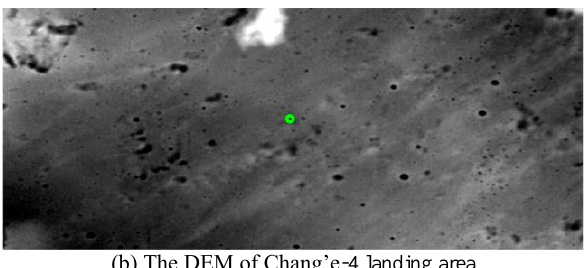
Figure 2. The DOM & DEM of Chang’e-4 landing area and the location of Chang’e-4 lander During the Chang’e-4 mission, the ground control station